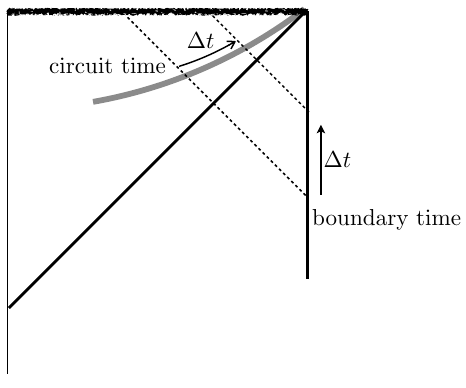
Figure 9 . Identi(cid:12)cation between circuit time and boundary